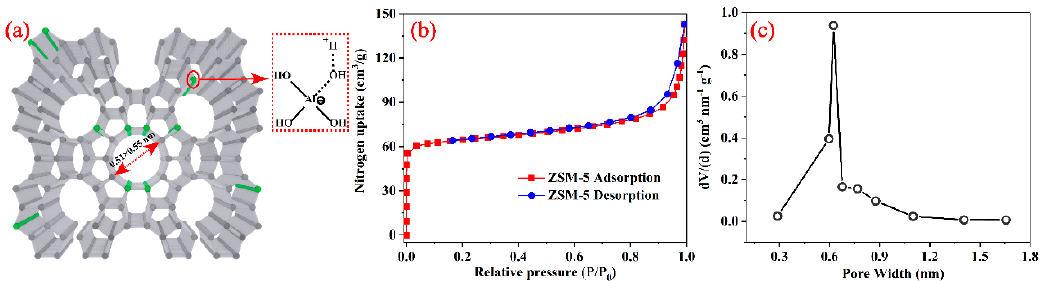
Figure 2. ( a ) Skeletal diagram, ( b ) nitrogen adsorption-desorption isotherms, and ( c ) pore size distribution profiles of ZSM-5 zeolite.